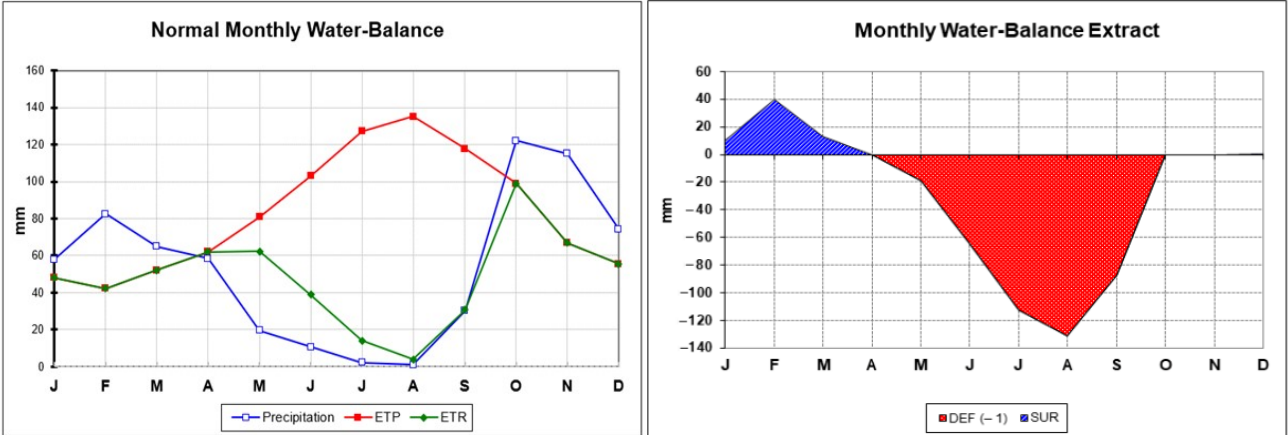
Figure 5. Calculation of water balance in the agrosystem of QV, including on the left monthly accumulate precipitation (blue line), Evapotranspiration potential (ETP, red line), and Real Evapotranspiration (ETR), and on the right monthly field hydric balance (blue diagram area) and soil water capacity (red diagram area).